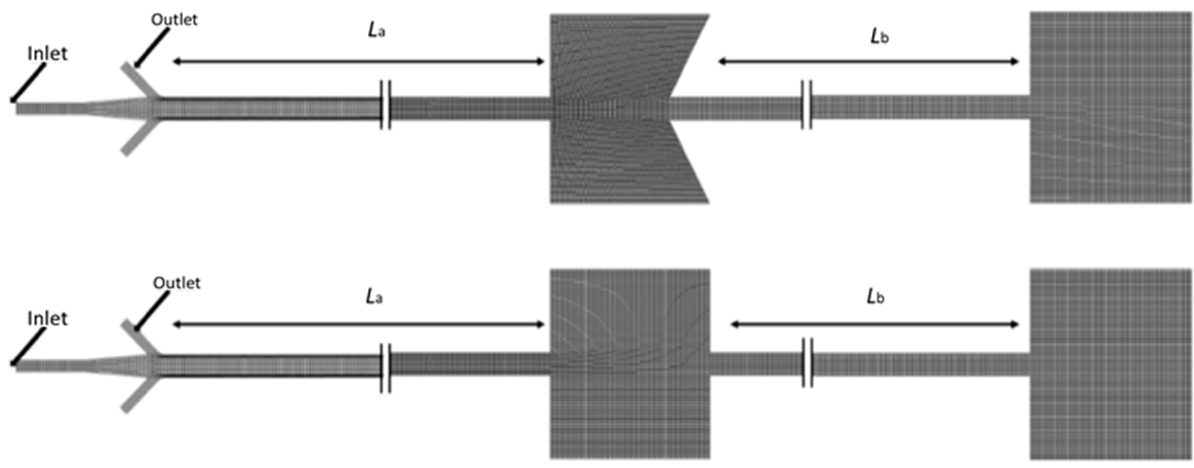
Figure 3. Structures and mesh of each type of gas wave